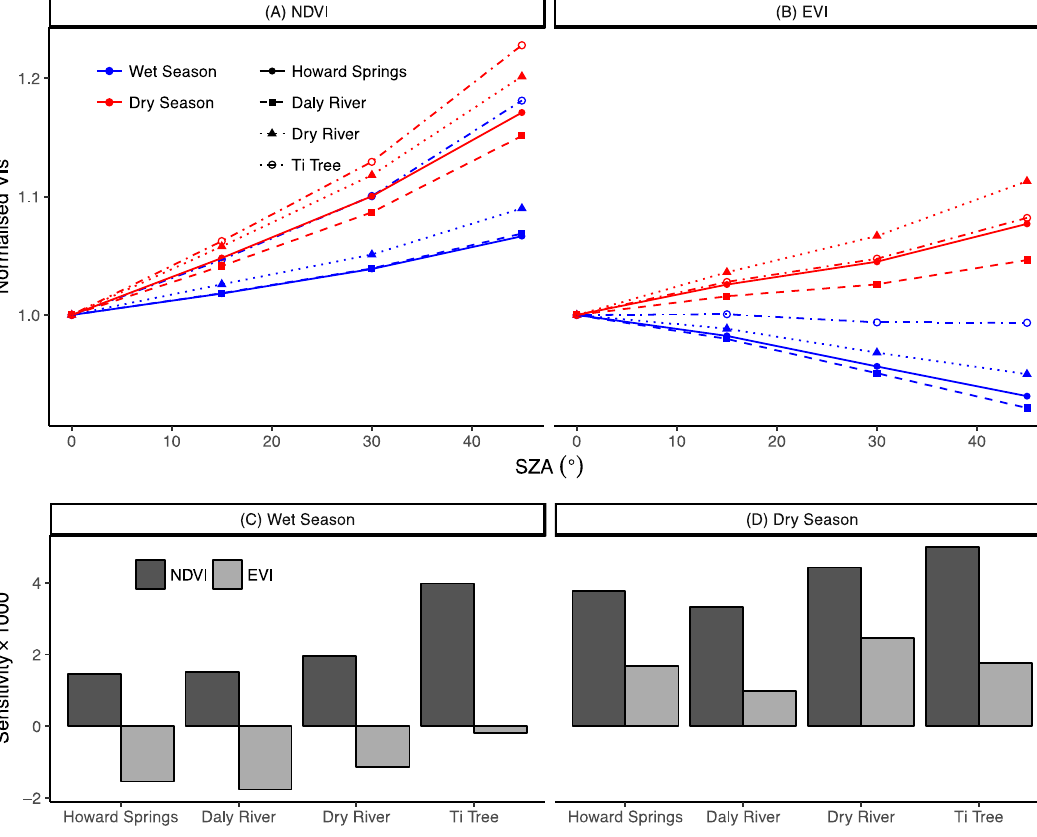
Figure 6. Sensitivity of vegetation indices to sun-angle variations. ( A ) Changes in NDVI with variations in sun-angle during the wet season (February) and the dry season (July), at four NATT sites. ( B ) Changes in EVI with variations in sun-angle during the wet season and dry season, at four NATT sites. ( C ) Comparison of the sensitivity of NDVI and EVI to changes in the sun-angle during the wet season, at four sites. ( D ) Comparison of the sensitivity of NDVI and EVI to changes in sun-angle during the dry season, at four sites. For each site, four VIs were simulated using the BRDF model by fixing the sun-angle at 0 ◦ , 15 ◦ , 30 ◦ and 45 ◦ . All NDVIs and EVIs have been adjusted to the nadir view. For comparison among sites, values have been normalised by VI SZA-0 for each site. Sensitivity is defined as change in VI per degree change of solar zenith angle (SZA).